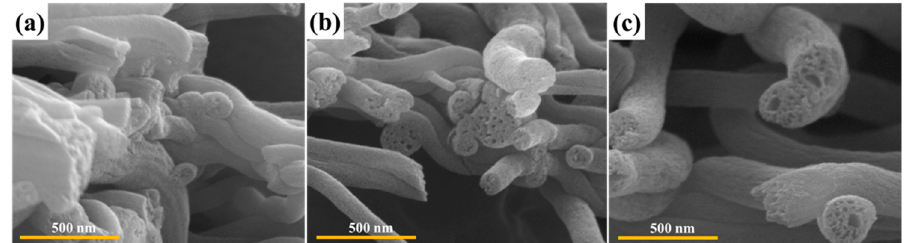
Figure 4. The cross-section SEM images of carbon nanofibers obtained with different weight ratio at